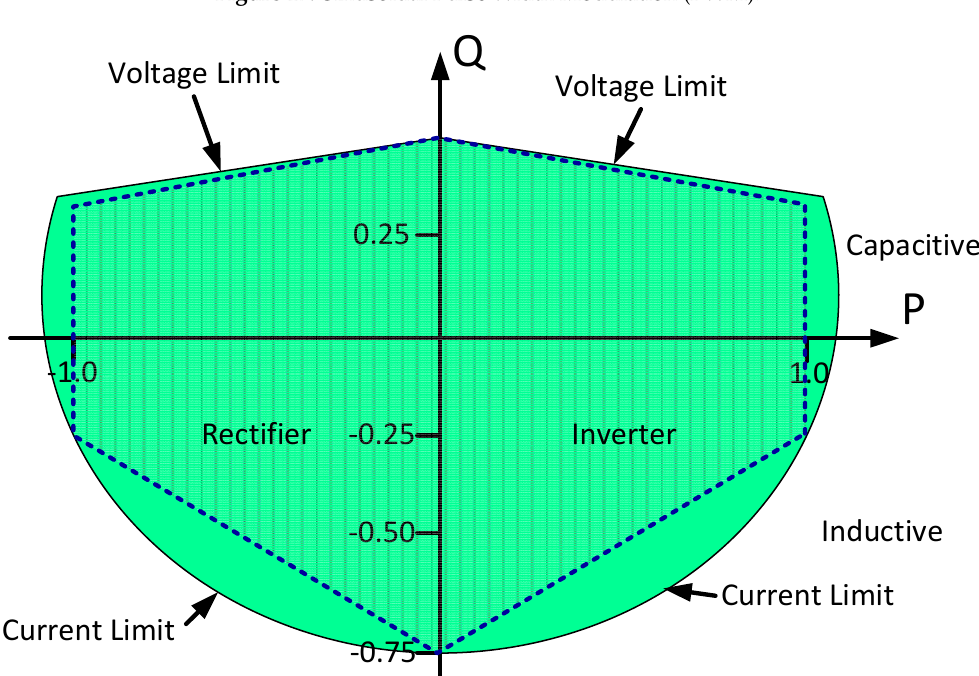
Figure 17. Sinusoidal Pulse Width Modulation (PWM).